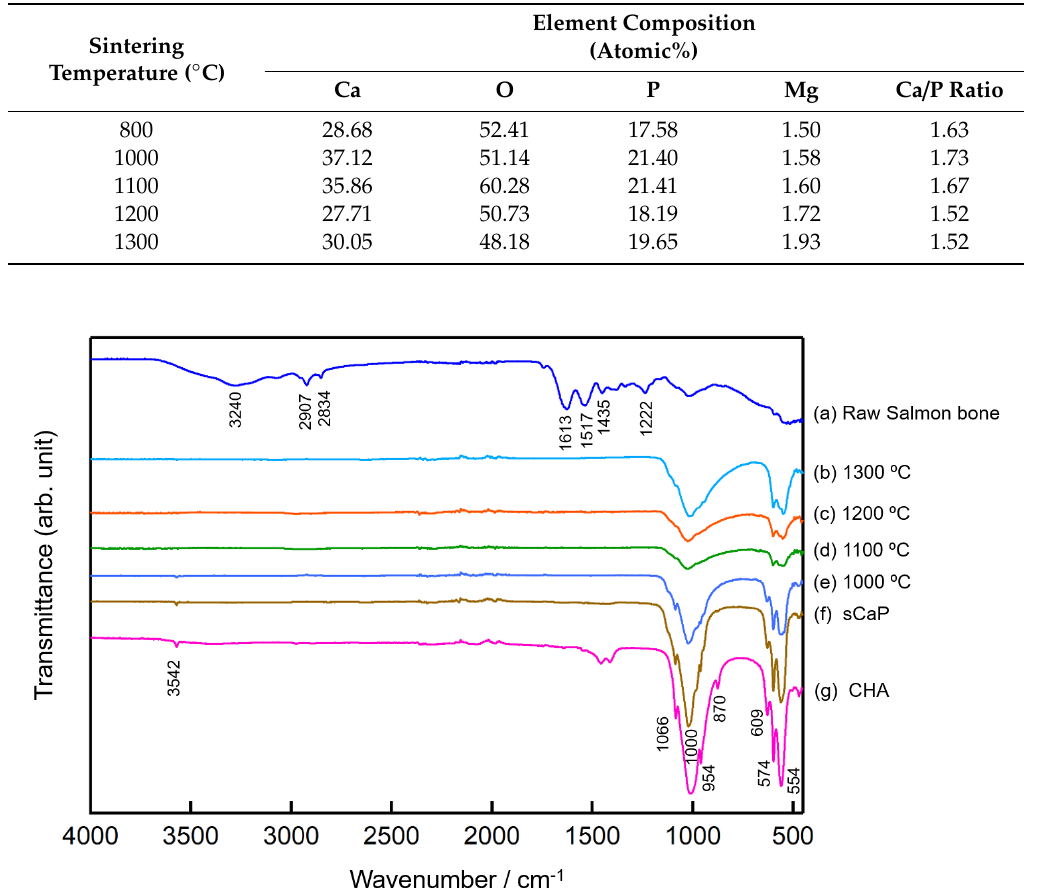
Table 2. EDX analysis and Ca / P ratios of sintered sCaP.